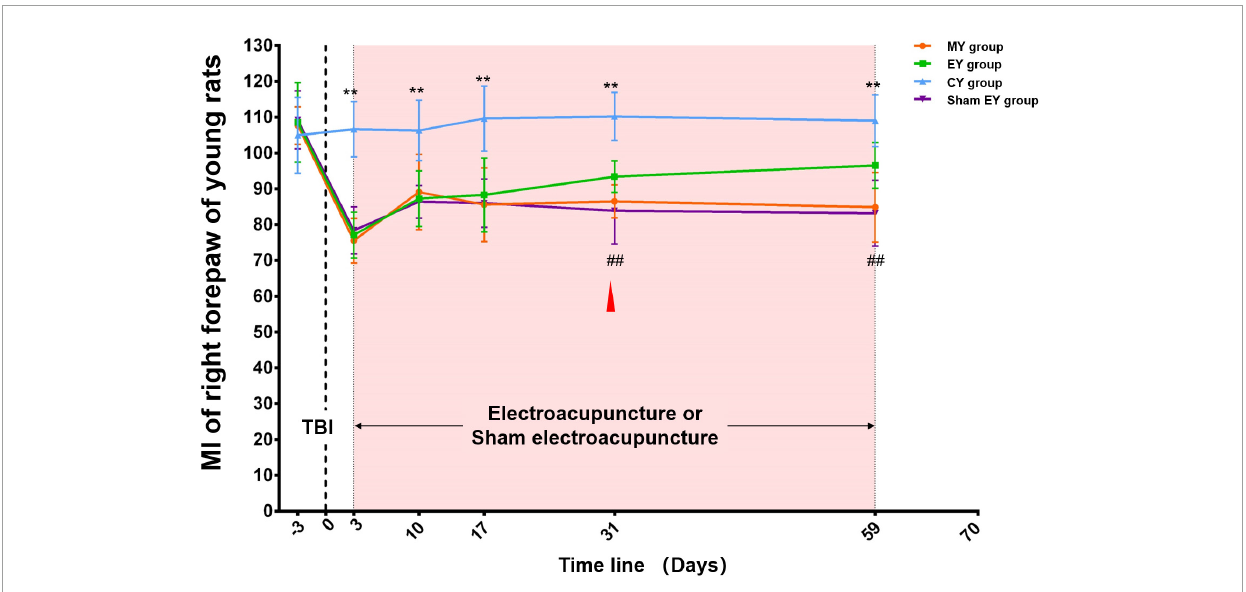
FIGURE3 Catwalk gait analysis of the right (injured) forepaw in young rat groups. At baseline, there was no difference among the four groups (MY, EY, sham EY, and CY groups) ( p > 0.05). After TBI, the MI of right forepaw of young rats in MY, EY, and sham EY groups showed an obvious decrease compared with that in the CY group. During the subsequent observation process, there was an increase in these three groups. Throughout the experimental procedure, the MI of the right forepaw in the CY group was stable and significantly higher than that in the MY group ( p < 0.01). After 4 weeks (day 31 post-TBI) of intervention, the MI of right forepaw of young rats in the EY group increased significantly compared with that in the sham EY group ( p < 0.01). TBI establishment was showed by the dotted line. Mean and SD were expressed by the points and bars. The duration of electroacupuncture or sham electroacupuncture intervention was marked out with the pink shadow. The red triangle represented the starting point of electroacupuncture for improving the young rats’ MI. MY group, young model group; EY group, young electroacupuncture group; CY group, young control group; sham EY group, young sham electroacupuncture group. TBI, traumatic brain injury; MI, the mean intensity. **Represented a significant difference between the CY and MY groups at the same time point ( p < 0.01). ##Represented a significant difference between the EY and sham EY groups at the same time point ( p <